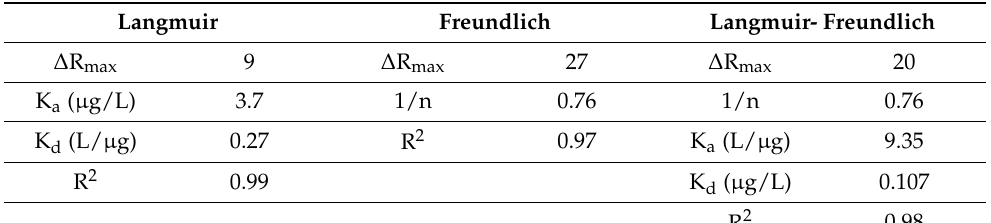
Table 2. The parameters of thermodynamic models isotherm.